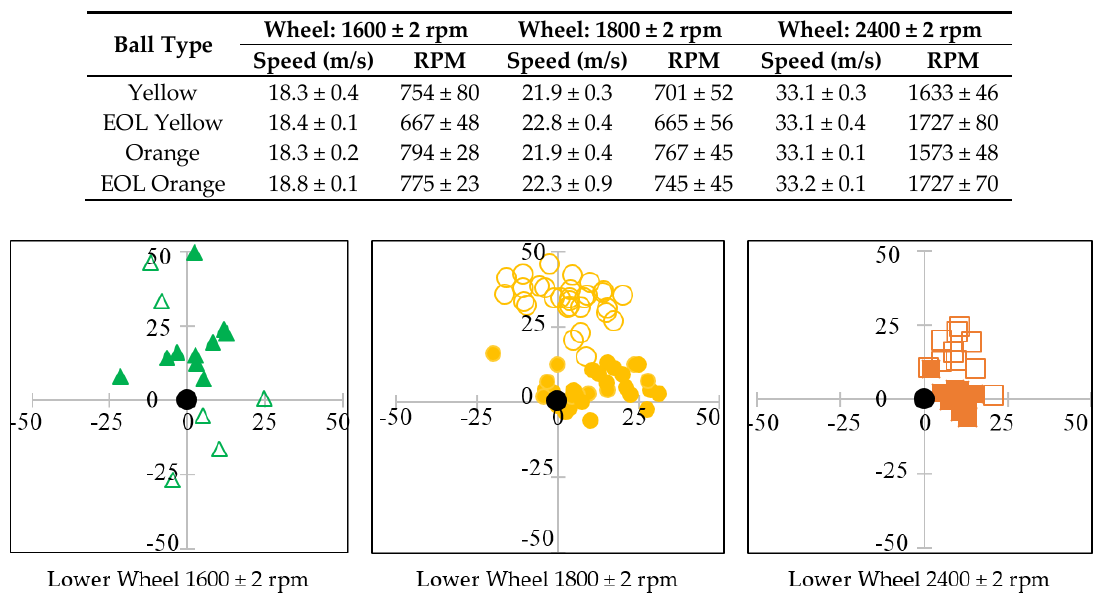
Table 1. Results of long-distance pitching experiments.